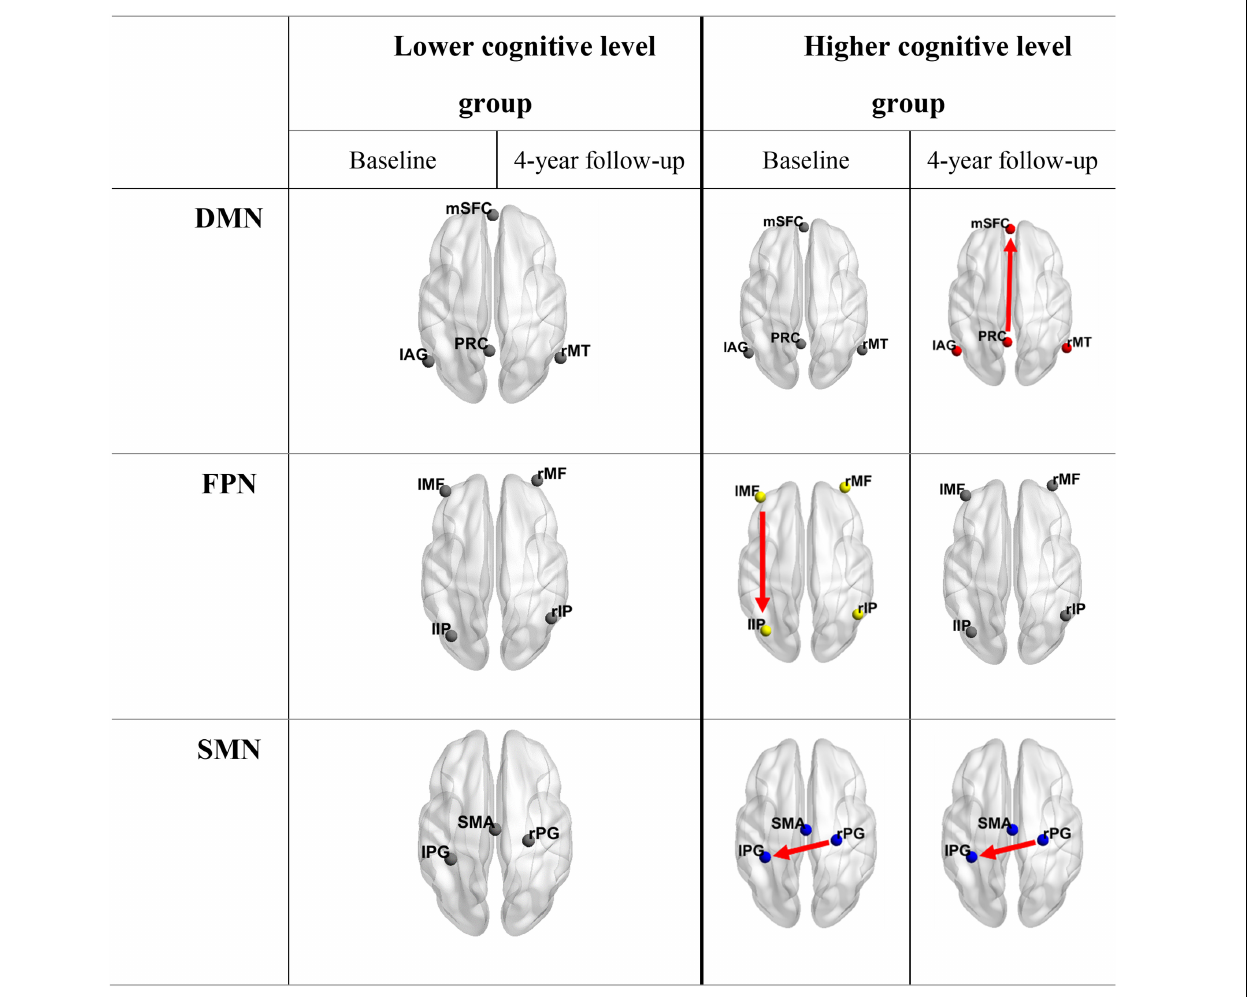
FIGURE 4 | Optimal models for groups with different cognition levels at both time points. Connections shown in the table are lost information propagation pathways compared to fully connected models. It is obvious that the lower cognitive level group invariably had fully connected models. DMN, default mode network; FPN, fronto-parietal network; SMN, somatomotor network; mSFC, medial superior frontal cortex; PRC, precuneus; lAG, left angular gyrus; rMT, right middle temporal gyrus; l/rMF, left/right middle frontal gyrus; l/rIP, left/right inferior parietal gyrus; SMA, supplementary motor area; l/rPG = left/right postcentral